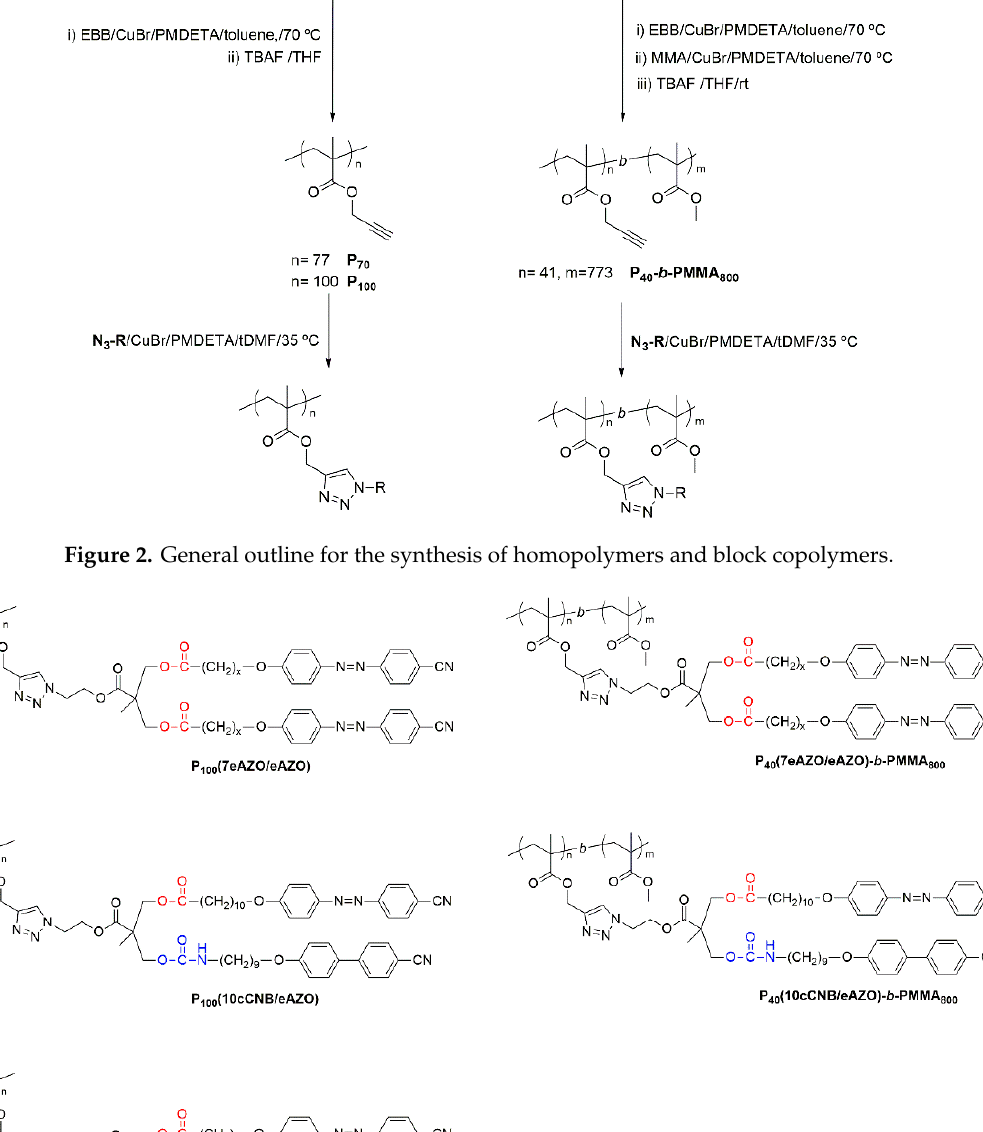
Figure 3. Chemical structure of homo- and block polymers discussed in this work.